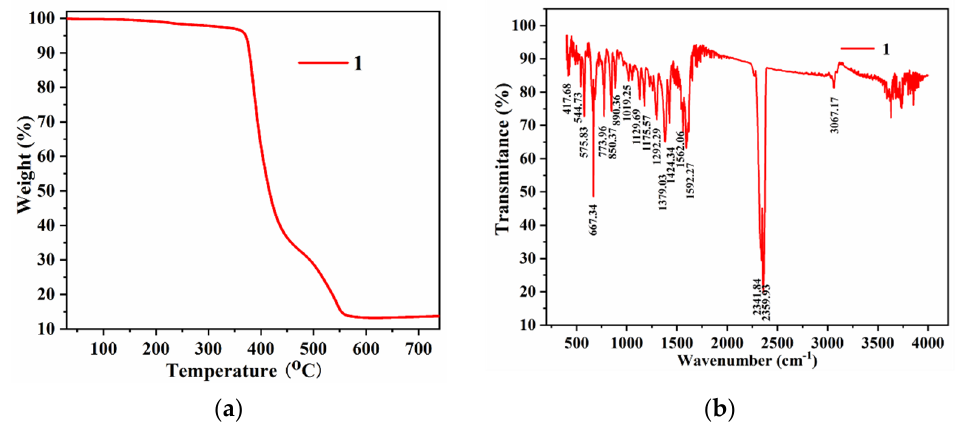
Figure 2. ( a )Thermogravimetric analysis curve of 1 ( a ); IR spectrum of complex 1 ( b ). Figure 2. Thermogravimetric analysis curve of 1 ( a ); IR spectrum of complex 1 ( b